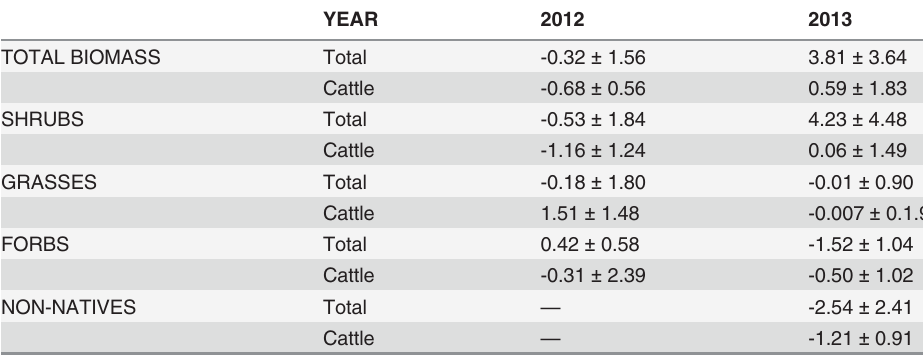
Table 2. Biomass effect